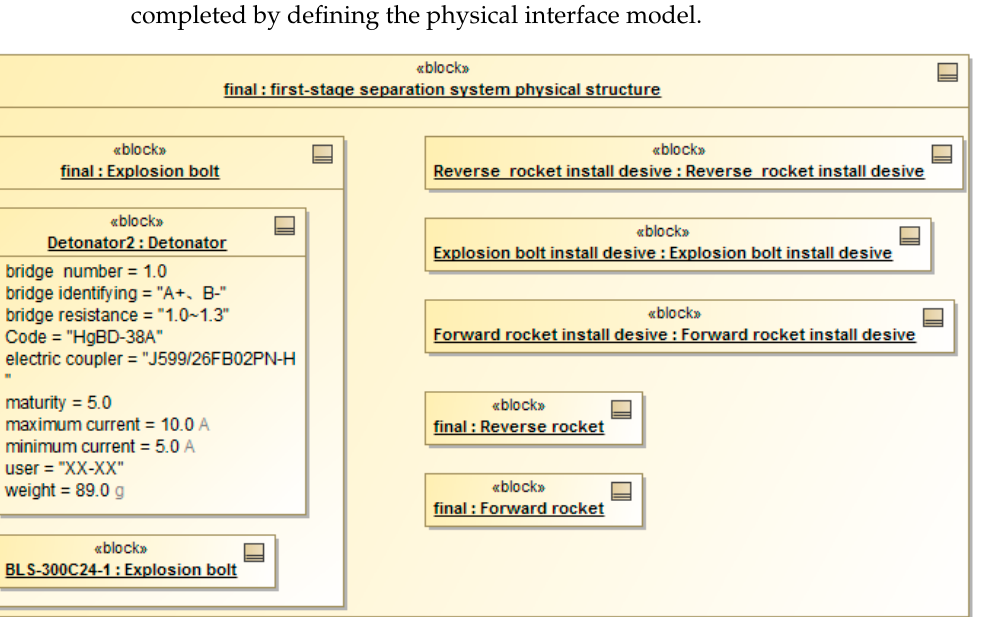
Figure 10. Logical compose of first-stage separation system.